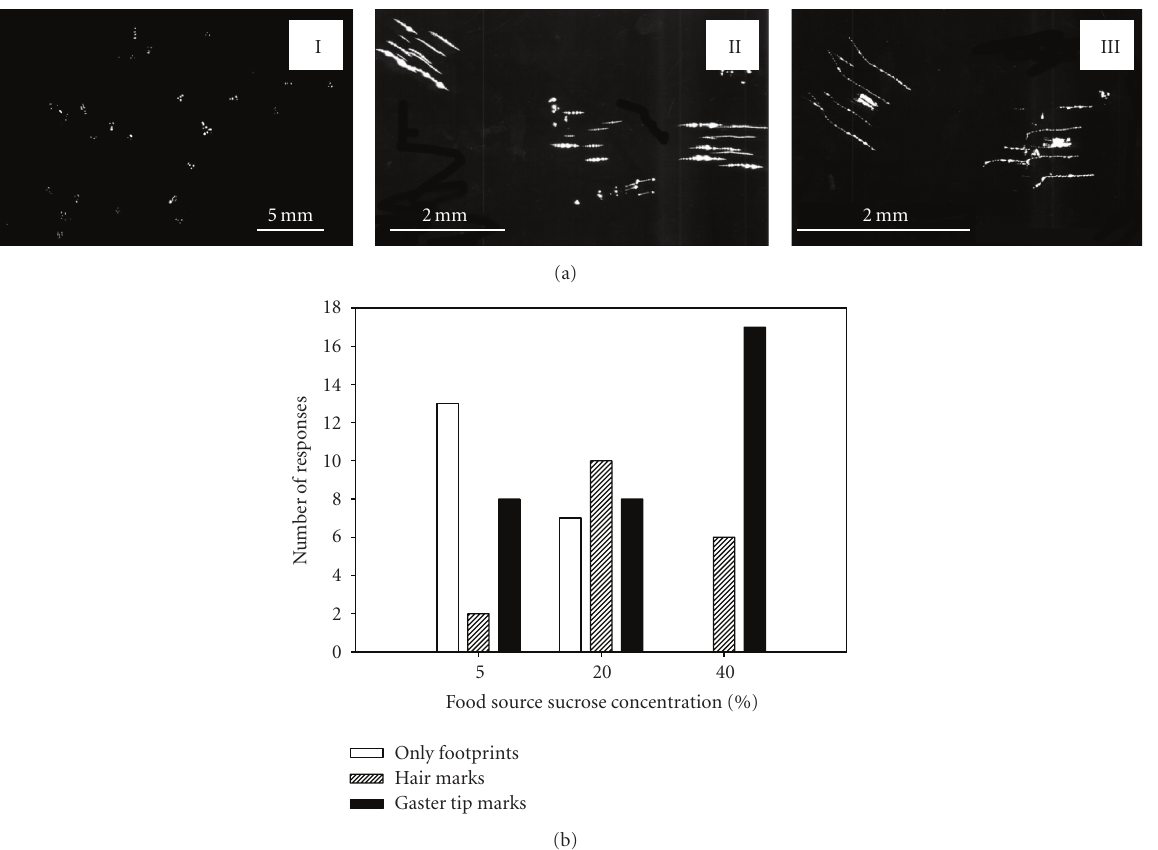
Figure 3: (a) Examples of the di ff erent marks left by C. rufipes ants: (I) only footprints, (II) hair marks, and (III) gaster-tip combined with hair marks; (b) number of marks left by the foragers after the first and fourth visits to the bait for 5%, 20%, and 40% sucrose